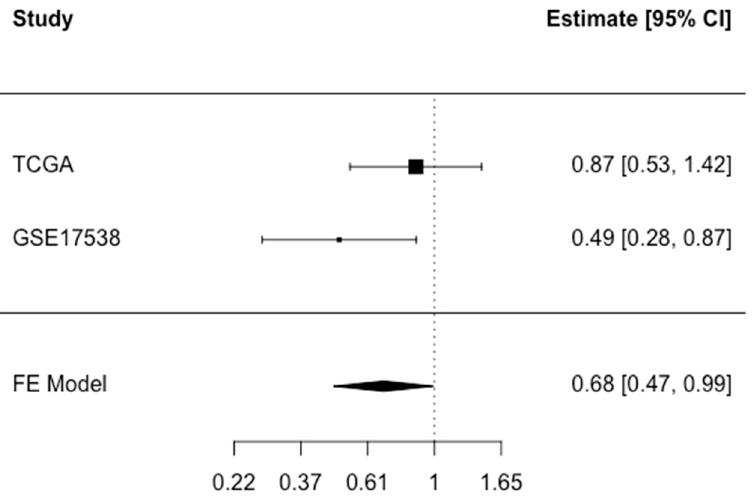
Figure 3. Meta-analysis of disease-specific death associated with CFTR expression dichotomized at median in TCGA COADREAD and GSE17538. Fixed effect (FE) meta-analysis HR (95% CI): 0.68 (0.47–0.99) for high versus low CFTR expression. Test for heterogeneity p =